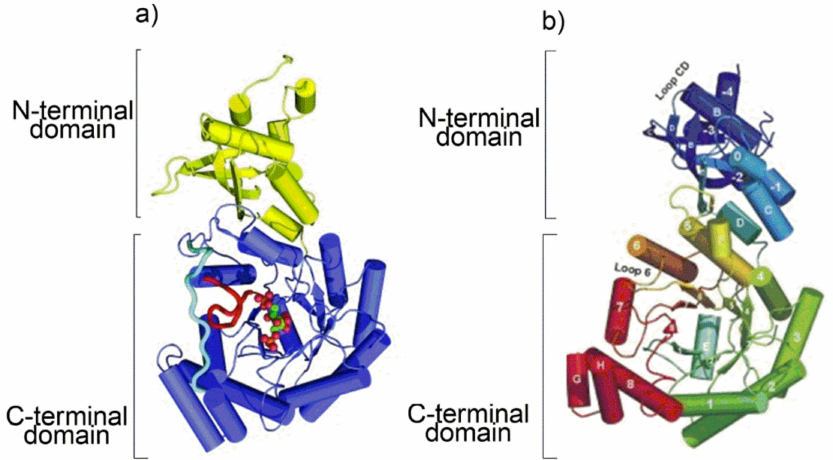
Figure 2. Tertiary structure folding of the L subunit of Rubisco from: ( a ) Arabidopsis thaliana (form I Rubisco); ( b ) Chorobium tepidum (Rubisco-like protein). One 2CABP molecule is shown bound at the active site of Arabidopsis thaliana . The figure evidences α -helices (as solid cylinders) and β -strands (as arrows) and the TIM-barrel unit at the C-terminal domain. Loop 6 is evidenced in red in both representations. Loop CD is also shown as a peculiarity of RLP (Figure 2a from ref. [17], used without changes from original source distributed under the CC-BY licence, http: //scripts.iucr.org/cgi-bin/paper?S2059798317017132 (accessed on 25 June 2021). Figure 2b from ref. [21], adapted and used by permission of Elsevier (copyright ©